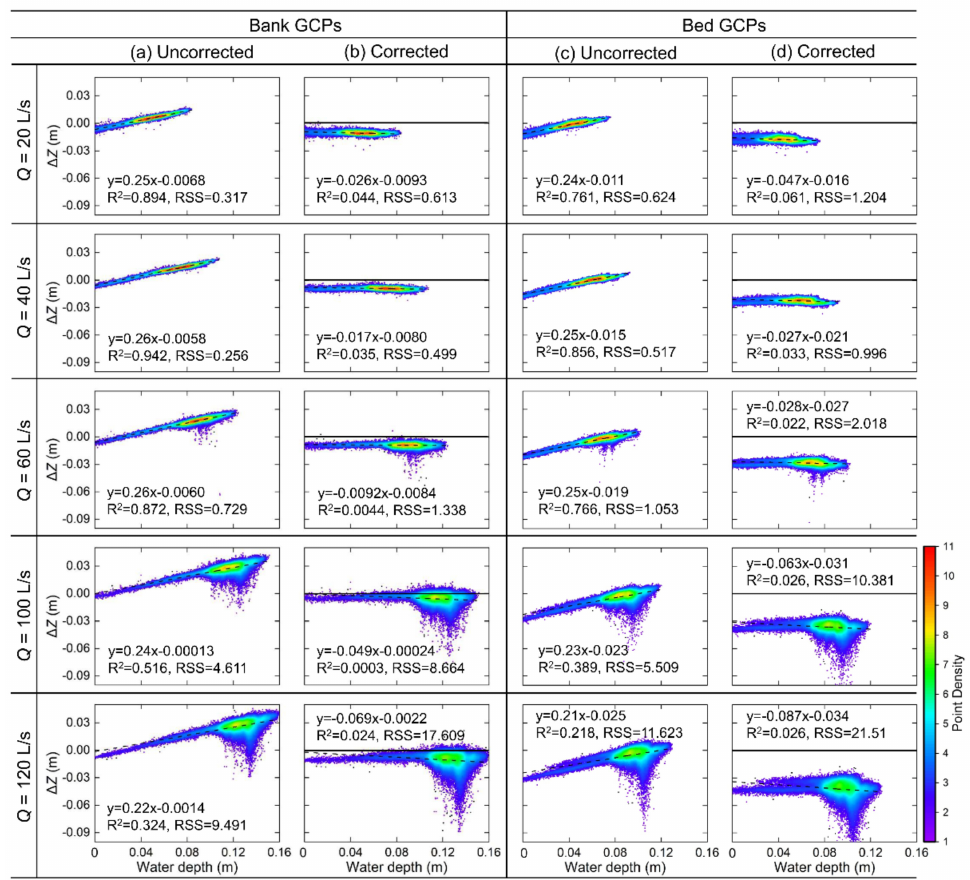
Figure 9. Relations between water depth and elevation error for MR1: ( a , b ) for the uncorrected and corrected models with the bank GCPs, respectively; ( c , d ) for the uncorrected and corrected models with the bed GCPs, respectively. Point density refers to the point number at each plotted point location. Linear regression for each relation is presented with the regression equation, R-square, and residual sum of squares